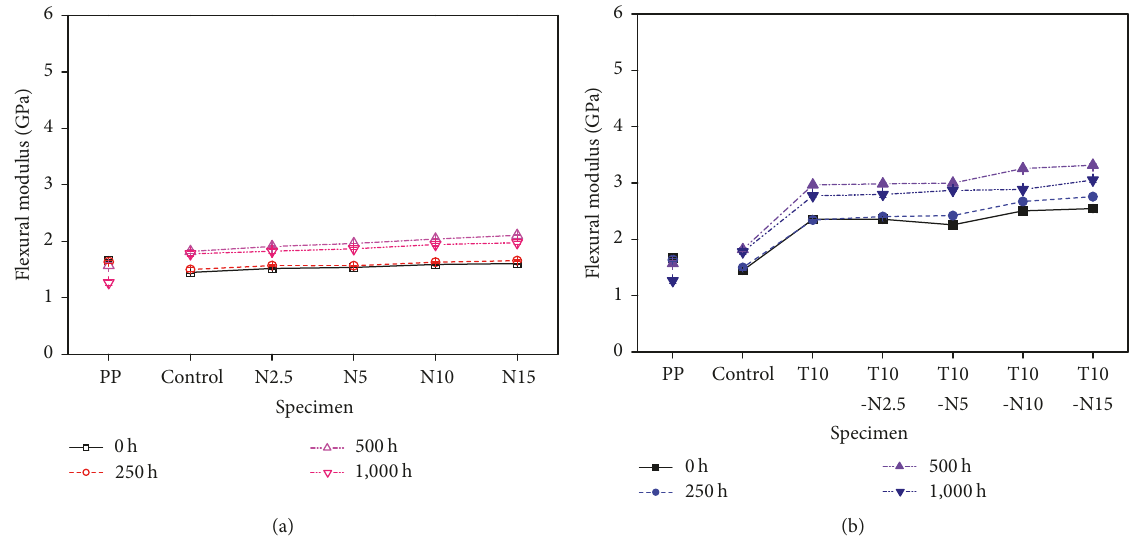
Figure 4: Flexural modulus of pure PP, control, and PP-based composites depending on accelerated weathering time: (a) NCC-only; (b)